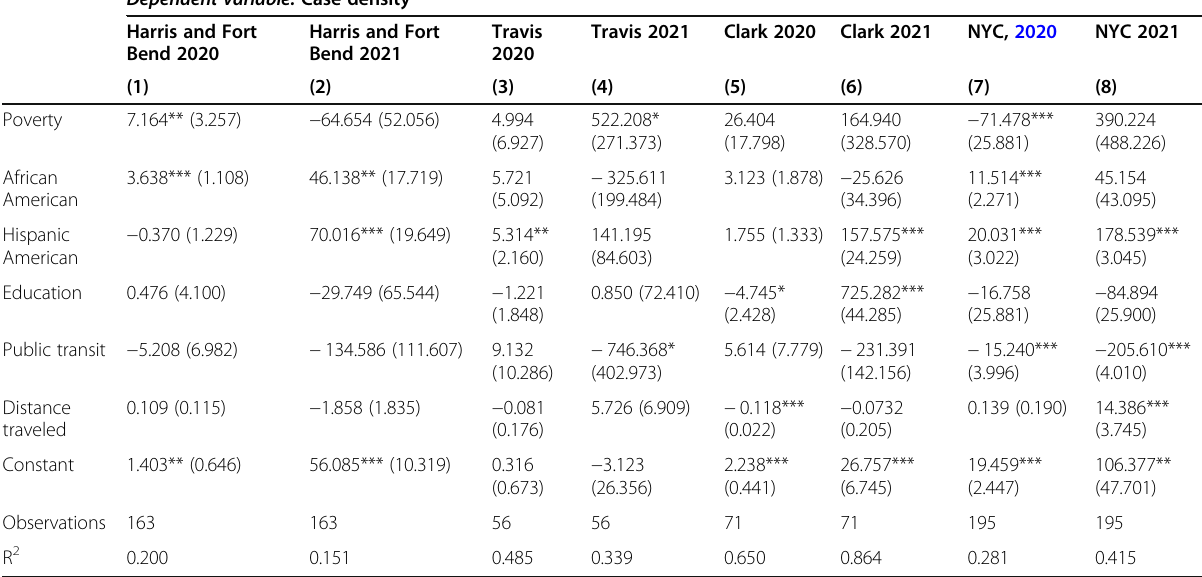
Table 2 OLS results Dependent variable: Case